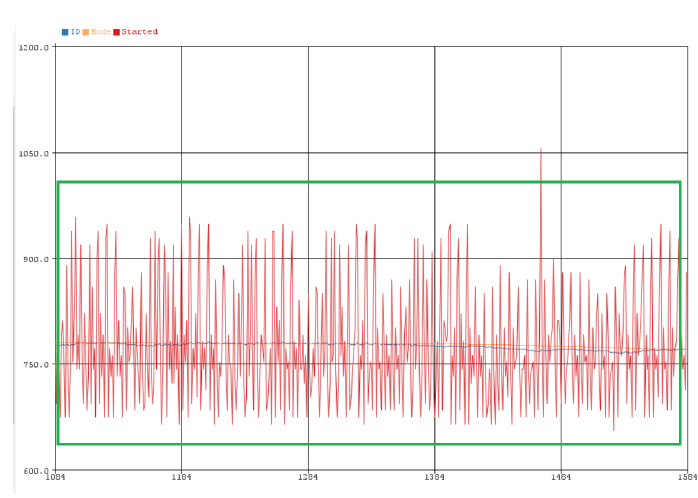
Figure 12. Intrusion Detection Mode 1.